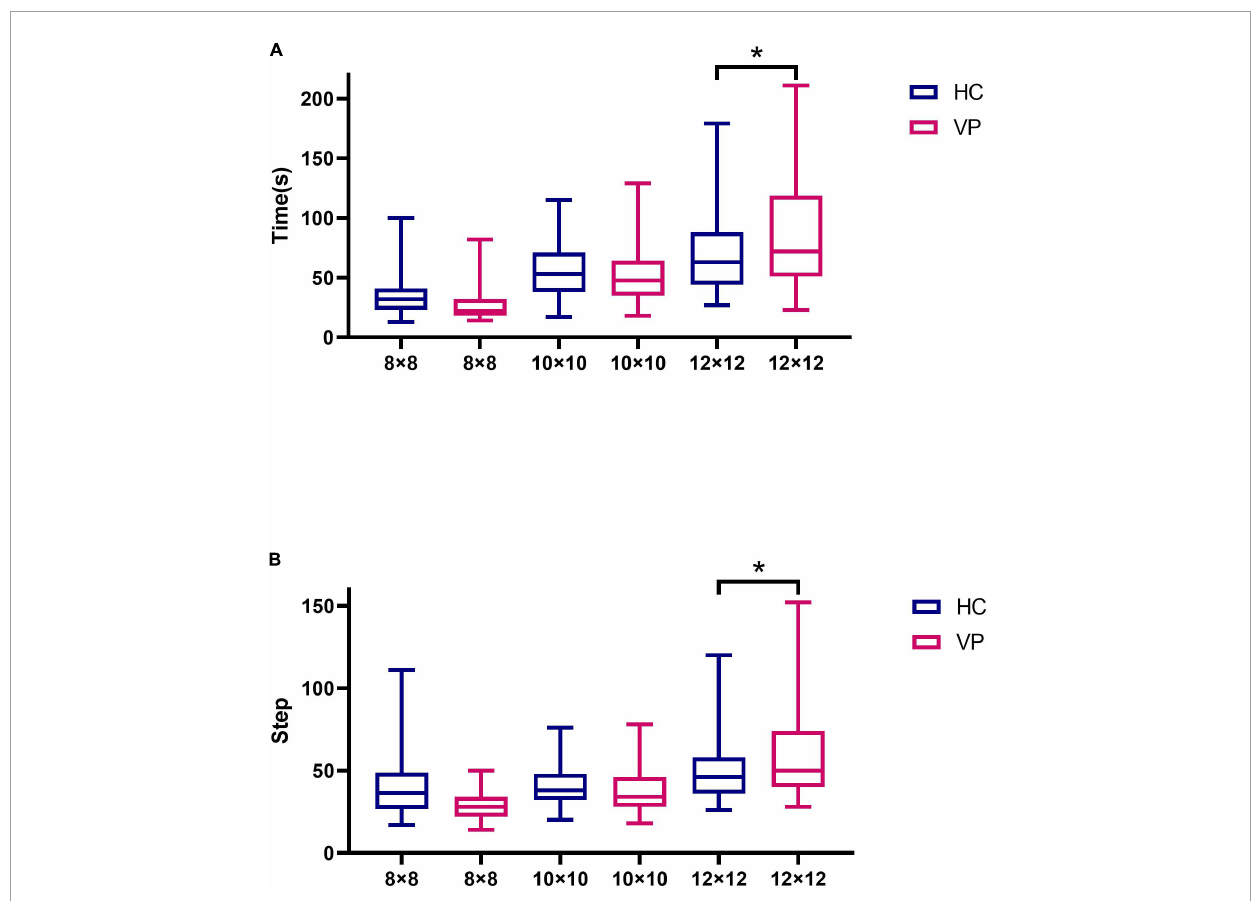
FIGURE11 Comparison of maze test indexes between VP and HC. (A) Time spent in maze tests of 8 × 8, 10 × 10, and 12 × 12 difficulty for VP and HC, respectively. (B) The number of steps in maze tests of 8 × 8, 10 × 10, and 12 × 12 difficulty for VP and HC, respectively. The upper and lower lines represent the 95th and 5th percentiles, respectively, and the horizontal line within the box is the median. VP, patients with vertigo; HC, healthy controls. * P < 0.05.